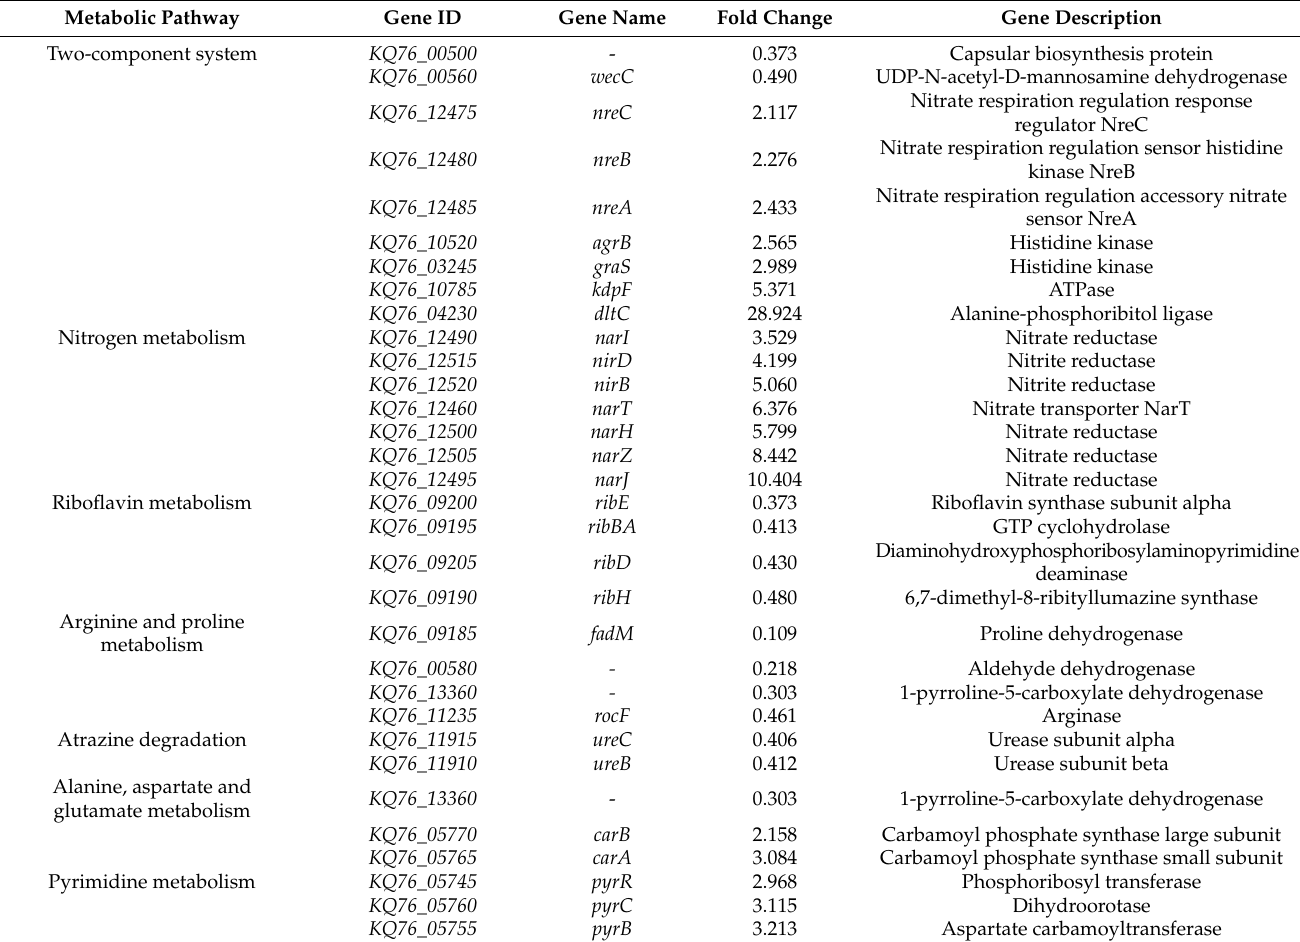
Table 5. The major altered metabolic pathways in S. aureus